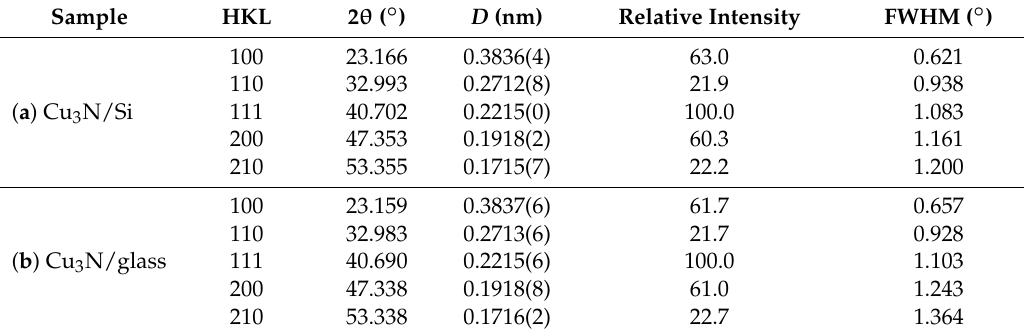
Table 1. XRD results of deposited Cu 3 N films on ( a ) Si and ( b ) glass